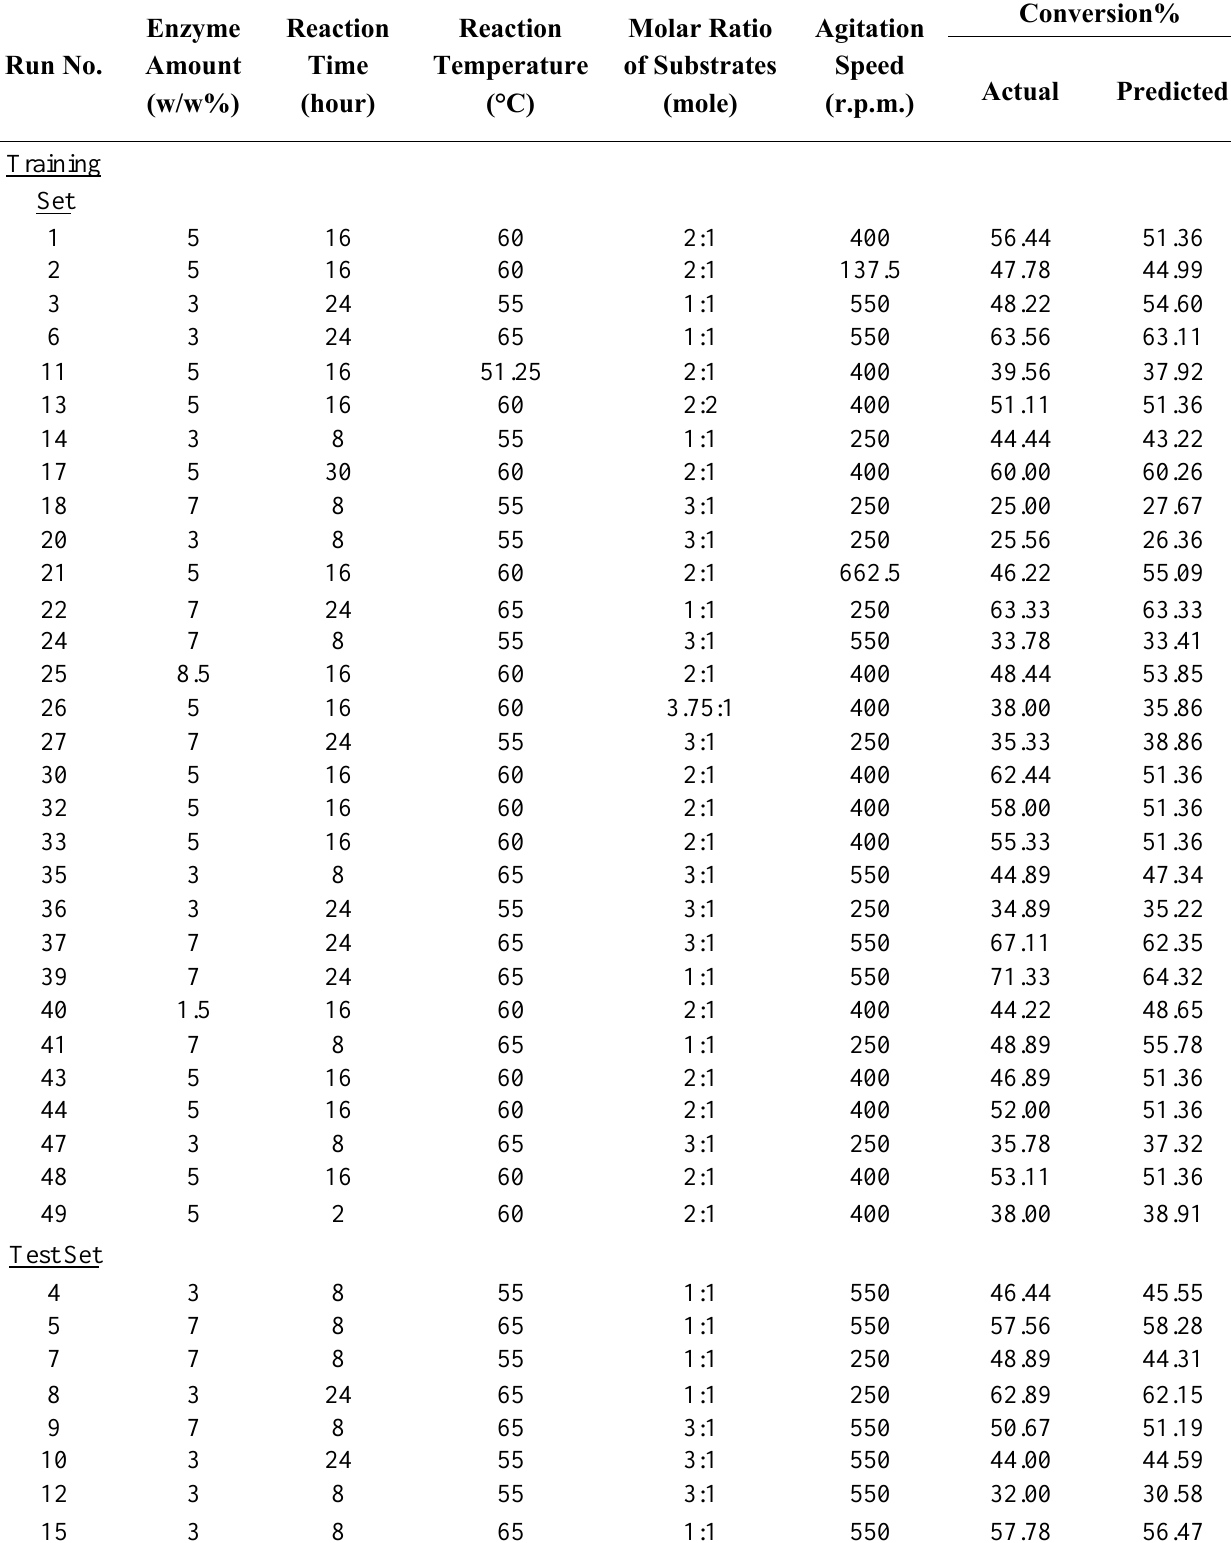
Table 1. Actual and predicted values of the ANN model of TEA-based esterquat cationic surfactant